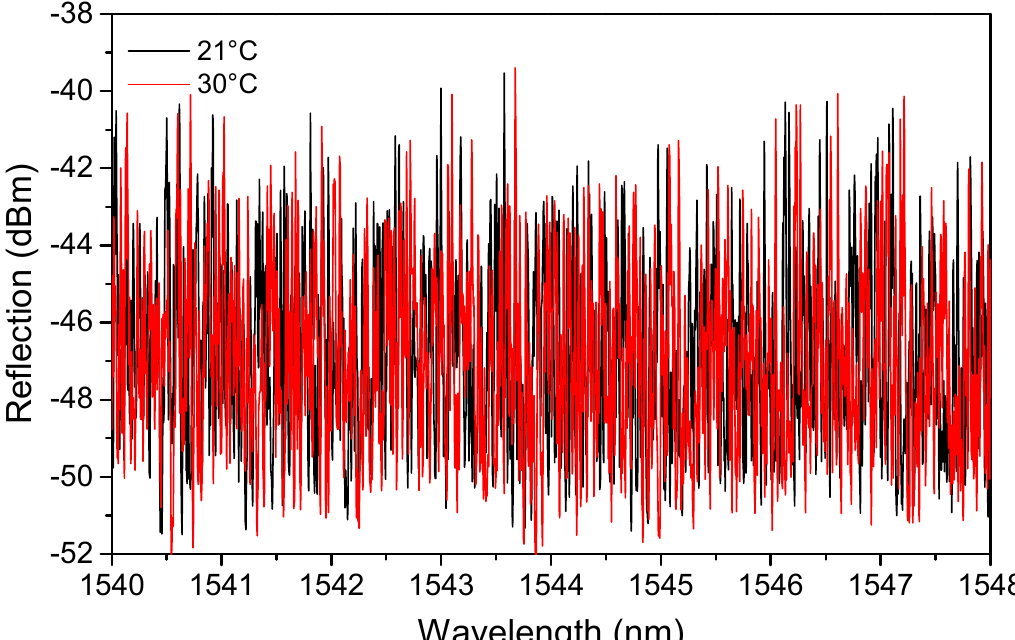
Figure 16. A part of reflection spectra of a type II 10 cm long FRG, inscribed in a Ge-doped fiber (the Corning SMF28e) with an fs-laser (at 800 nm), acquired at two temperatures, in order to highlight the changes induced by a temperature variation of about 10 °C. Data extracted from [114].